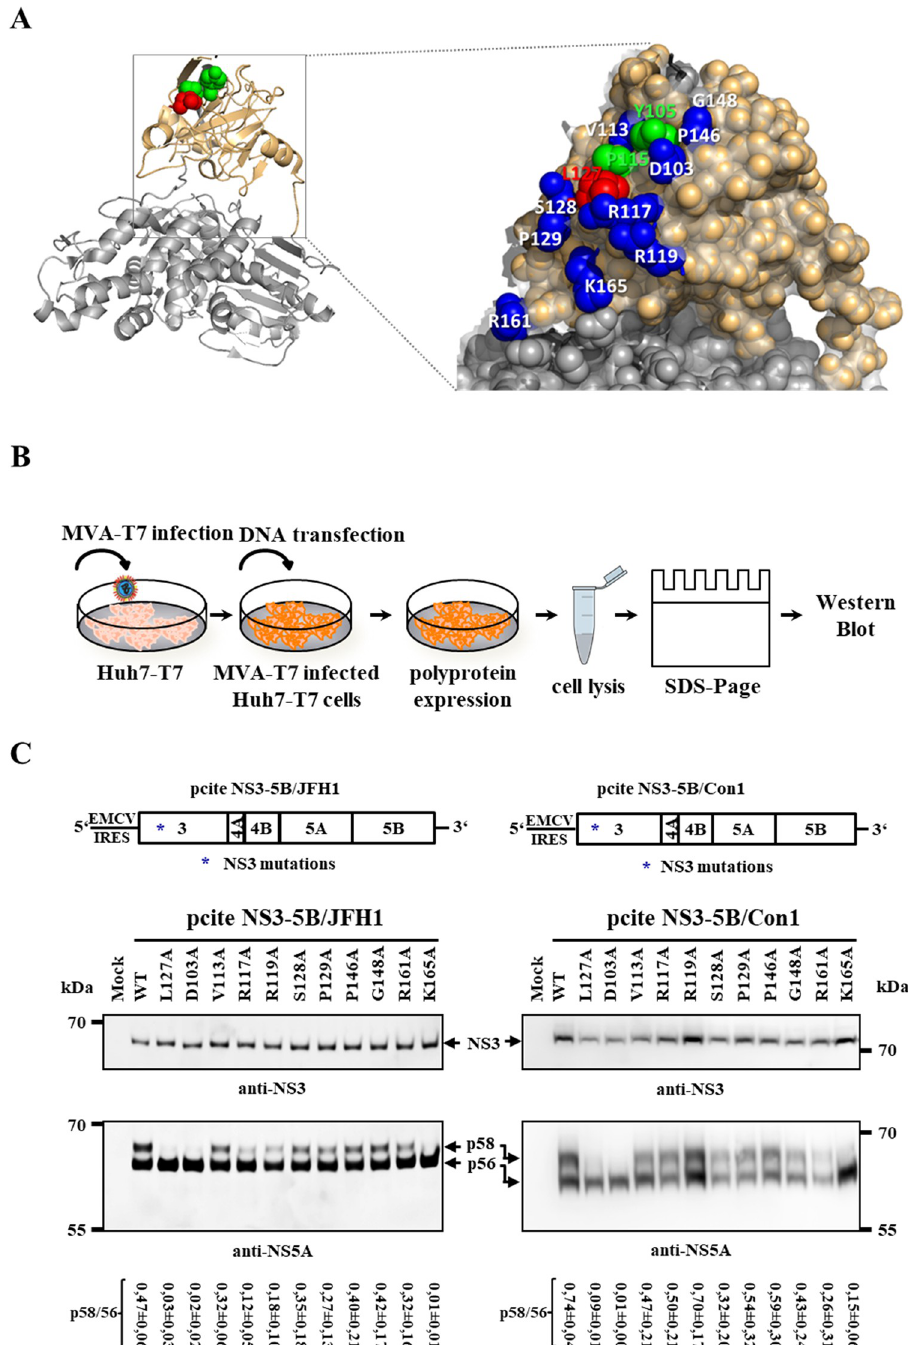
Fig 1. Identification of amino acids on the NS3 protease domain important for NS5A hyperphosporylation. (A) Presentation of the analyzed NS3 protease surface amino acids in the NS3 structure. Left: Ribbon diagram of NS3, highlighting the protease (brown) and helicase (grey) domain. Right: Magnified section of the NS3 protease surface encompassing residue L127 critical for RC assembly. Indicated are surface amino acids (blue spheres) in close proximity to L127 (red sphere) which were analyzed by alanine scanning mutagenesis. Residues (Y105, P115) known from earlier studies [43] to have no effect on NS5A hyperphosphorylation or RNA replication are depicted in green spheres. The illustrations were generated in PyMOL (version 1.10) using coordinates saved in PDB code 1CU1 [57]. (B) Workflow of the MVA-T7 pol expression system for replication-independent analysis of polyprotein processing and NS5A hyperphosphorylation of HCV polyprotein derivatives. NS3 mutations were introduced into